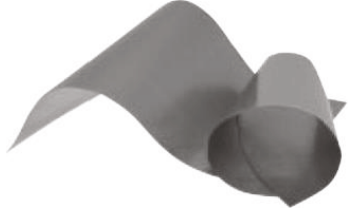
Figure 3: Pyrolytic Graphite Sheet